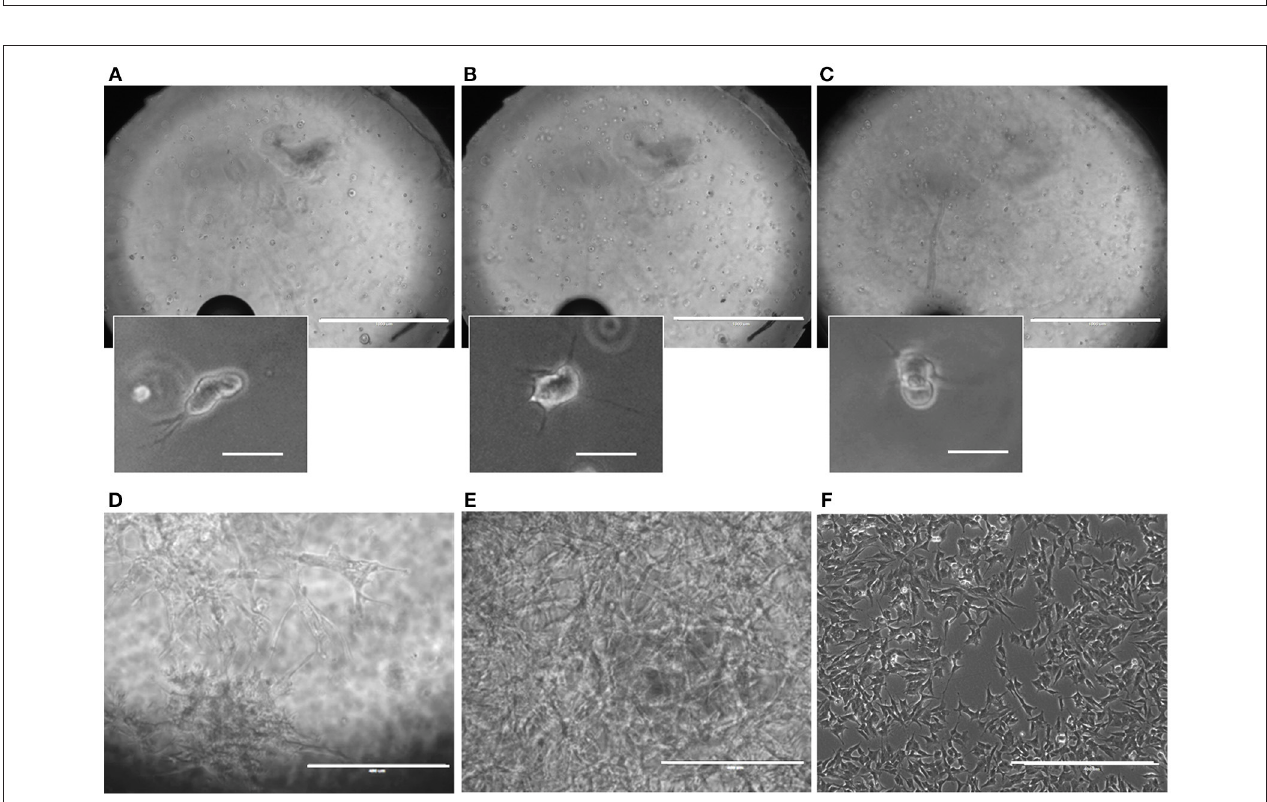
FIGURE 3 | Microbioreactor on MEA before and during neuronal cell culture. (A–C) Representative overview images taken of the SH-SY5Y neuroblastoma culture in the Matrigel within the microbioreactor on a glass cover slip at 1 DIV at focal planes near the cover slip (A) , the middle (B) , and the top (C) of the 3D cell culture. Small images indicate enlarged sections of the large images, showing SH-SY5Y cells that have started to produce outgrowths. The scale bars denote 1mm for the overview images and 100 µ m for the enlarged sections. (D) A representative image of differentiated SH-SY5Y cells at 14 DIV for 4 × 10 5 cells ml − 1 in a microbioreactor on top of a cover slip. The scale bar denotes 400 µ m. (E) Representative image of differentiated SH-SY5Y cells at 14 DIV for 4 × 10 6 cells ml − 1 in a microbioreactor on top of a cover slip. The scale bar denotes 400 µ m. (F) A representative image of 2D control culture of differentiated SH-SY5Y cells at 14 DIV. The scale bar denotes 400 µ m. For all images, the brightness was increased by 20% to increase